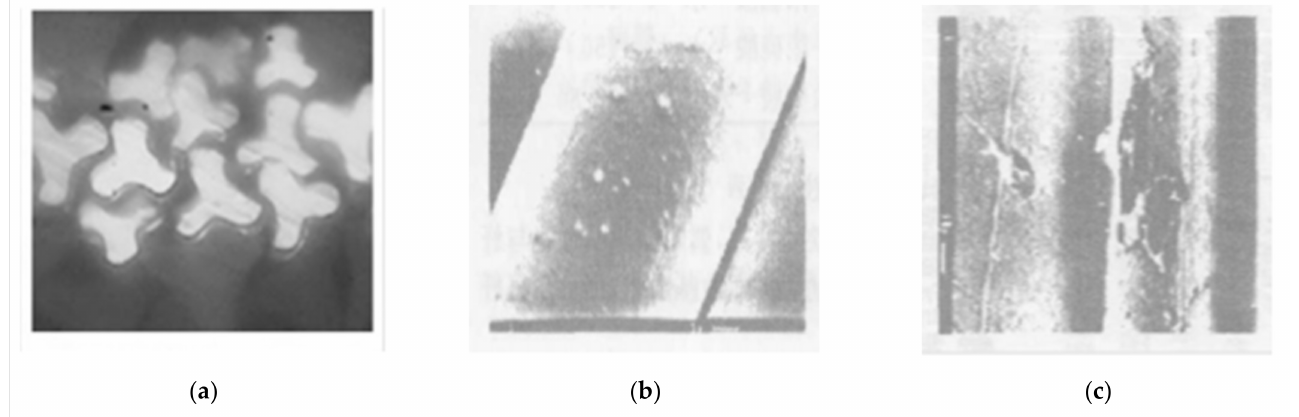
Figure 1. SEM comparison for PP fibers before and after surface treatment: ( a ) Y-shaped section; ( b ) ordinary PP fiber; ( c ) modified PP